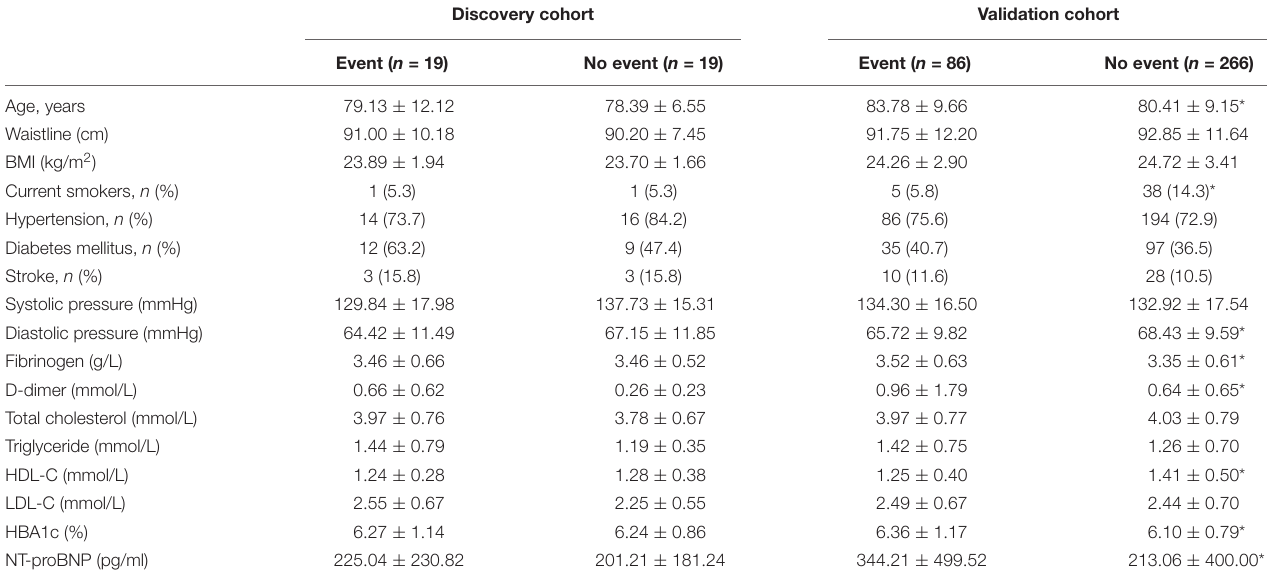
TABLE 1 | Baseline clinical and laboratory characteristics of the study